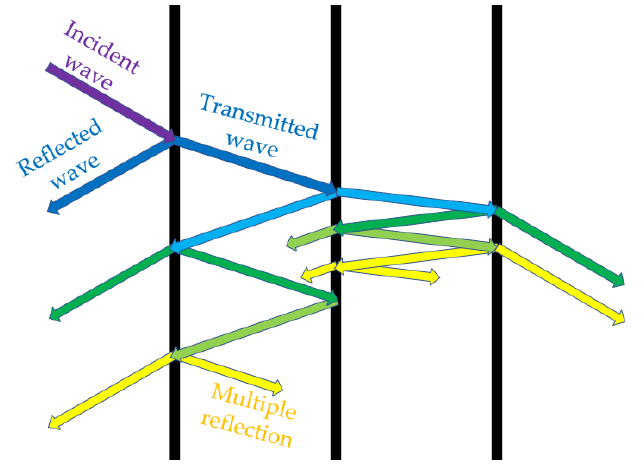
Figure 1. Schematic diagram of electromagnetic wave incidence .